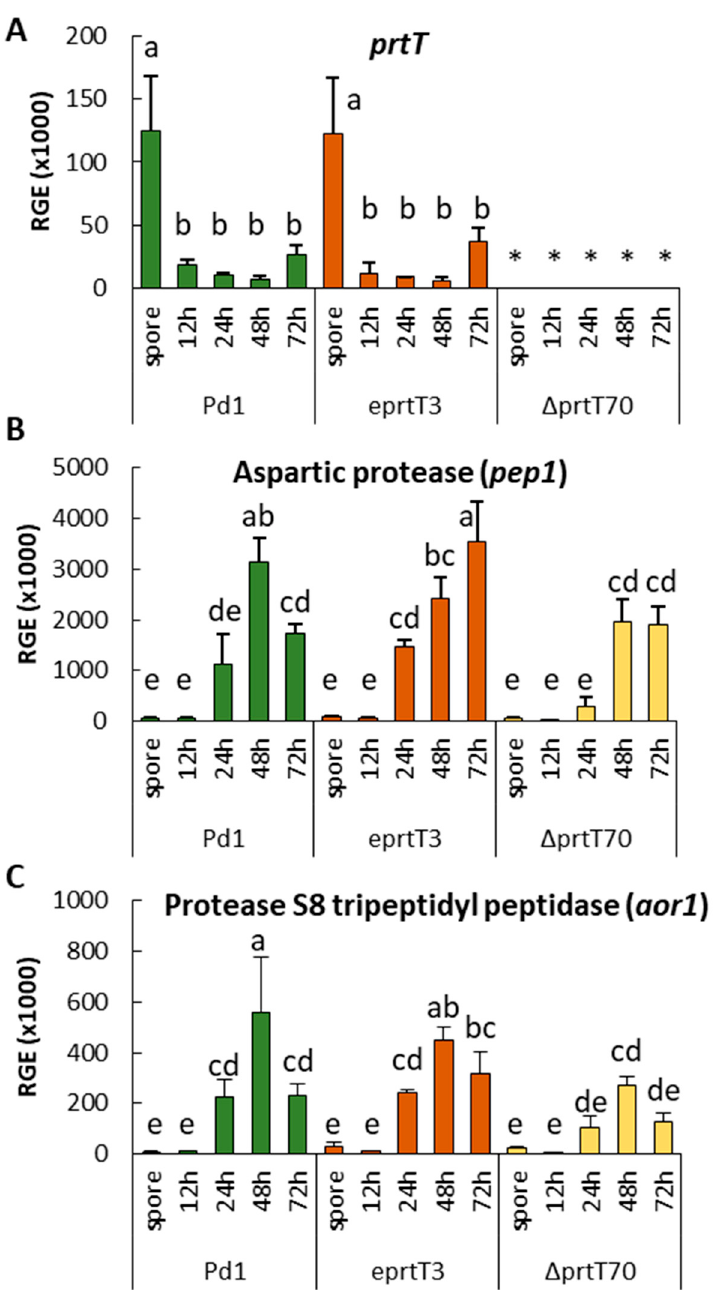
Figure 4. Analysis of normalized in vivo relative gene expression (RGE) in P. digitatum strain Pd1 (green bars), the ectopic e prtT 3 mutant (orange bars), and the knockout Δ prtT 70 mutant (yellow bars). The analysis was carried out in spores and at 12, 24, 48, and 72 hours after inoculation of orange fruits with the different strains. Bars show the mean values of three biological replicates and their standard deviations. The gene expression is relative to the P. digitatum actin gene as a reference. ( A ) PDIP_25240: Transcriptional activator of proteases, prtT ; ( B ) PDIP_82060: aspartic protease, pep1 ; and ( C ) PDIP_12220: putative protease S8 tripeptidyl peptidase I, aor1 . Bars labeled with the same letter indicate that there are no statistically significant differences at the 95% confidence level based on the Tukey’s test. The asterisk * indicates no expression level detected under the tested conditions.